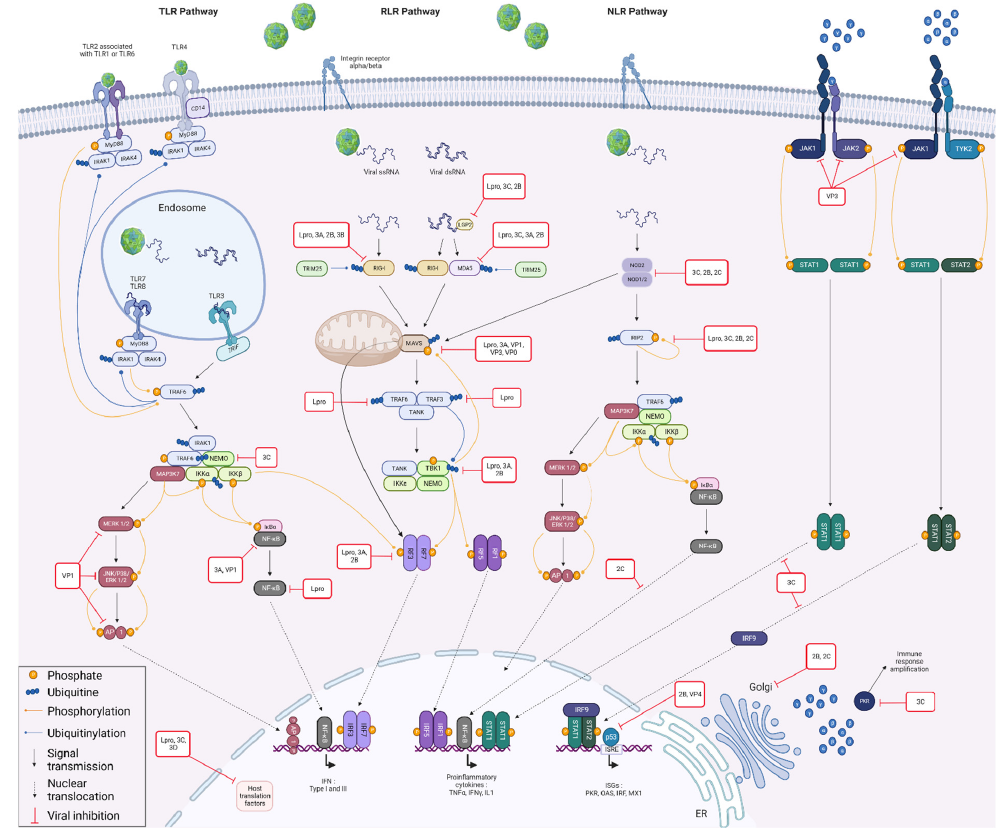
Figure 4. Innate antiviral immune responses and viral counteraction during FMDV infection. Co- evolution between FMDV and its hosts has led the virus to adopt a number of strategies for limiting the antiviral immune response. For example, it is able to interfere with viral RNA detection by acting on the RIG-I, MDA5, LGP2 and NOD2 sensors via its Lpro, 2B, 2C, 3A, 3B and 3C proteins. FMDV also antagonises the host immune response by targeting proteins involved in signal transduction, such as MAVS, RIP2, NEMO and TBK1, interacting via its VP0, VP3, VP1, Lpro, 2B, 2C, 3A and 3C proteins. In addition, Lpro protein of FMDV degrades IRF3 and IRF7, while 2B and 3A target only IRF3. MAPK pathway is restricted by the action of VP1, while NF-kB pathway is impacted by VP1, Lpro, 2C and 3A. FMDV also counteracts JAK/STAT pathway via VP3/JAK interaction and by pre- venting nuclear translocation of STAT dimers through 3C. At a nuclear level, Lpro, 3C and 3D are and some antiviral proteins, such as PKR, are degraded by 3C. Created with BioRender.com (ac- cessed on 16 August 2022).